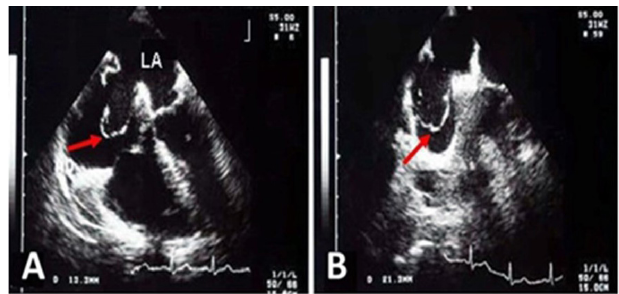
Fig. 2 - Transesophageal echocardiogram. A and B) The red arrow points to the atrial septal aneurysm. LA=left